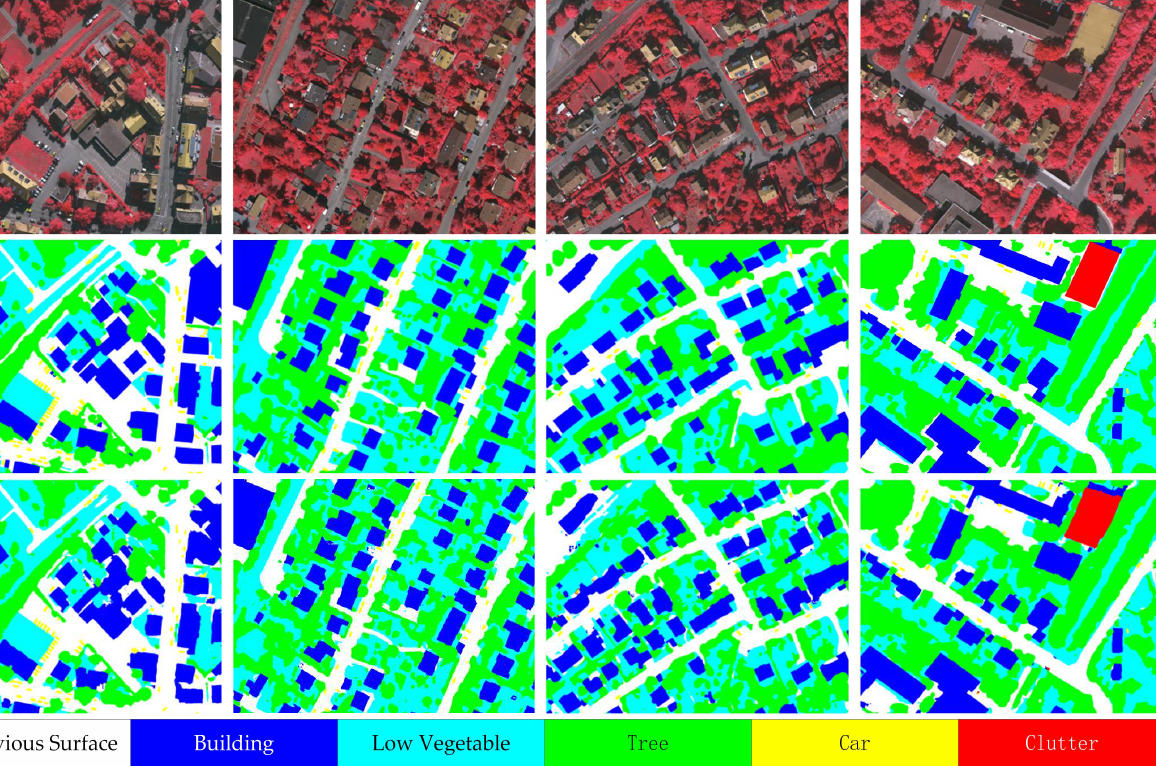
Figure 10. Results for large-scale images on the Vaihingen dataset. From top to bottom: large-scale image, ground truth, and segmentation maps predicted by HA-MPPNet.